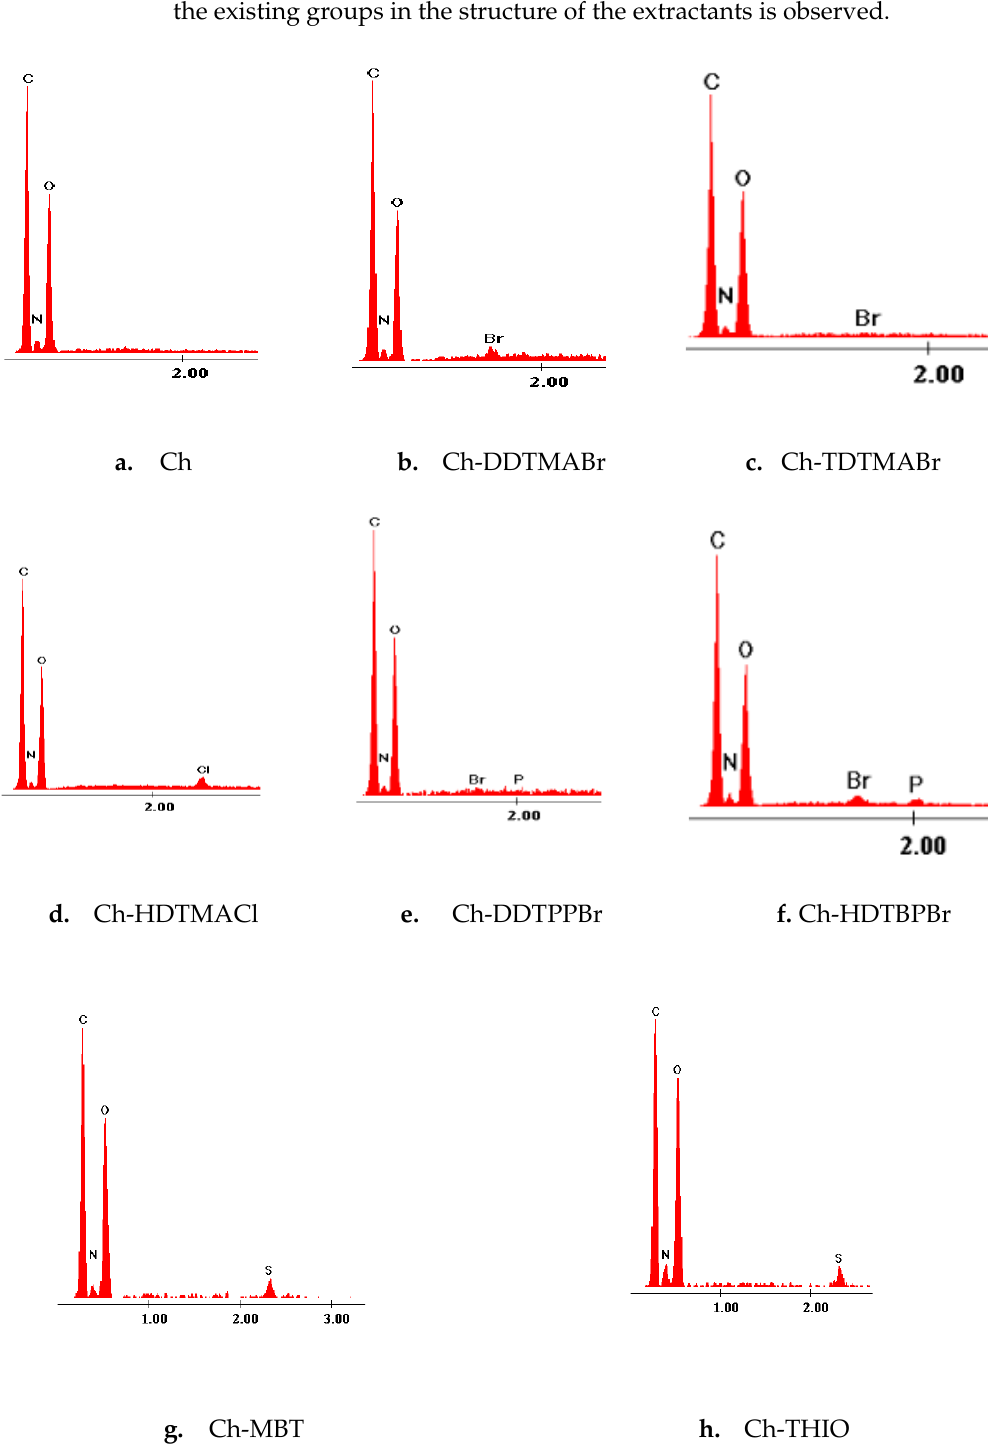
Figure 2. ( a – h ) EDX spectra for materials obtained by functionalizing chitosan with different extractants at ratio 10:1. By these means: